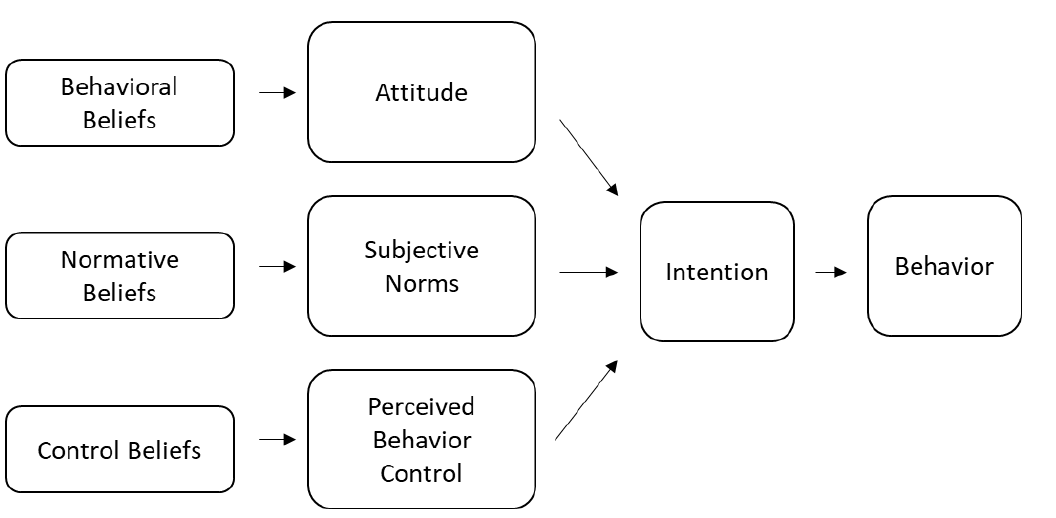
Figure 1. Theory of Planned Behavior Model (Ajzen,